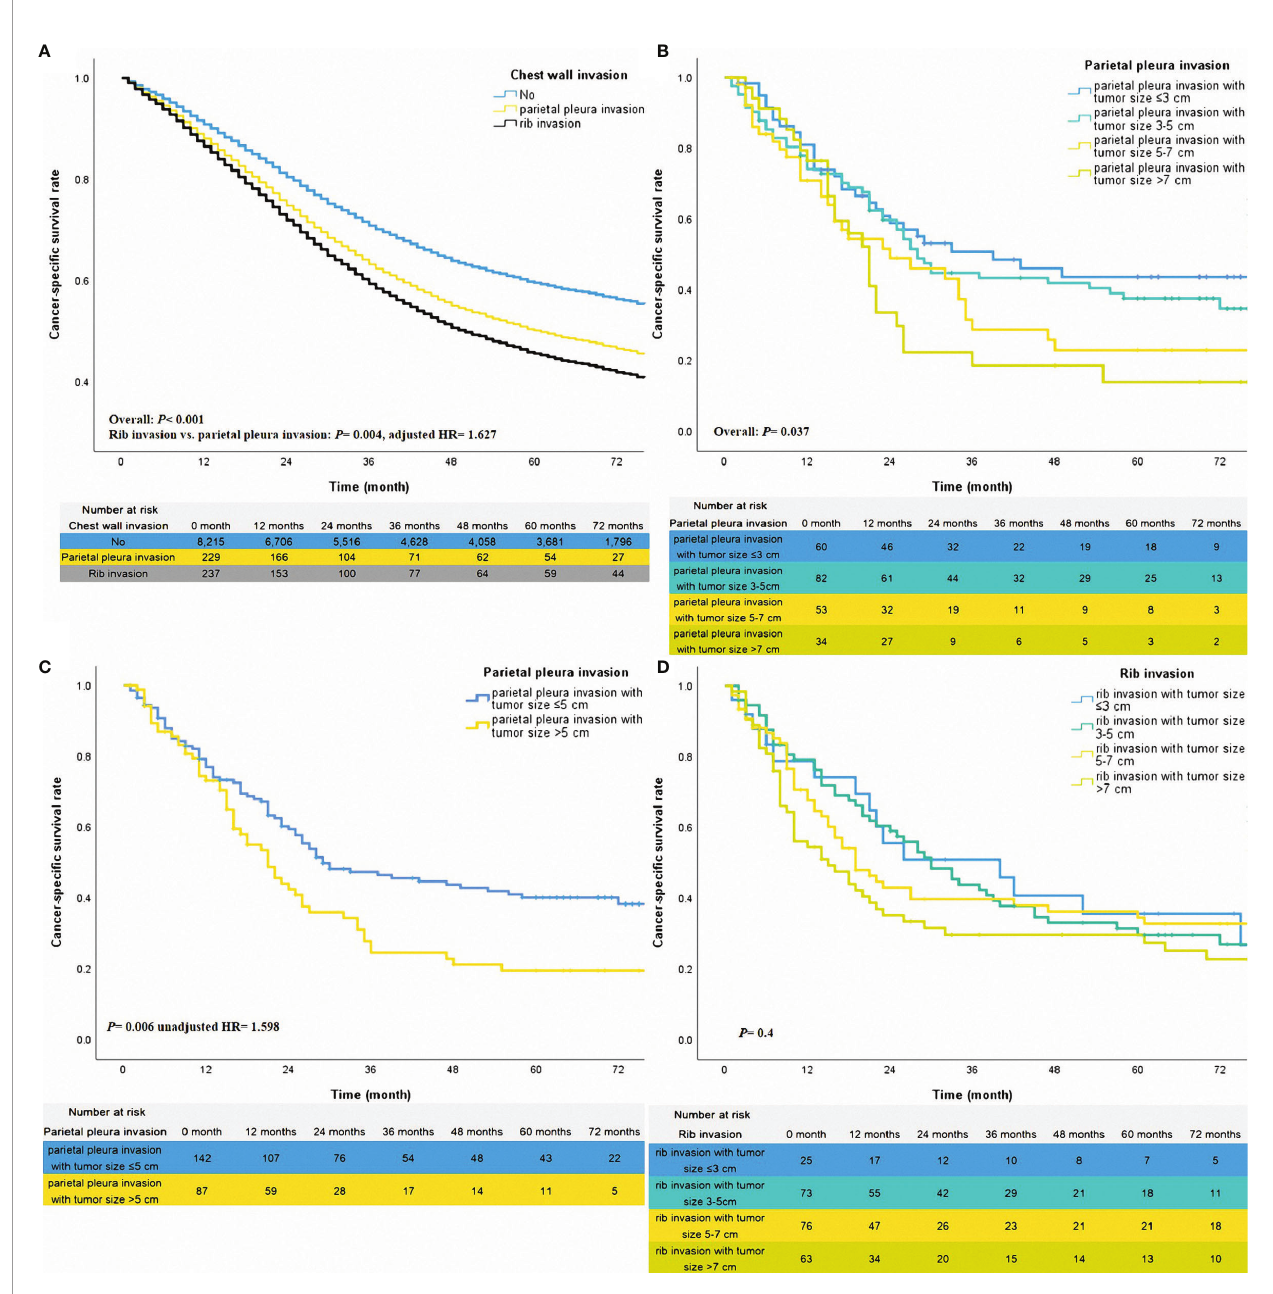
FIGURE 2 | The adjusted survival curves for different statuses of chest wall invasion (A) . The unadjusted survival curves for different classi fi cations of parietal pleura invasion (B, C) and rib invasion (D)